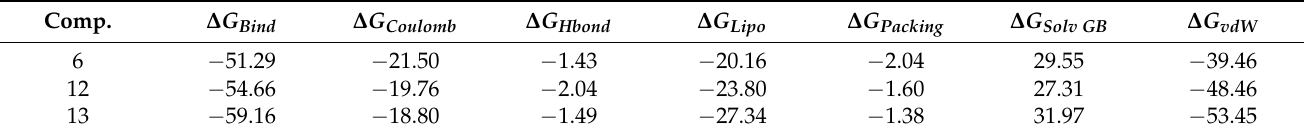
Table 3. Binding energies of the synthesized